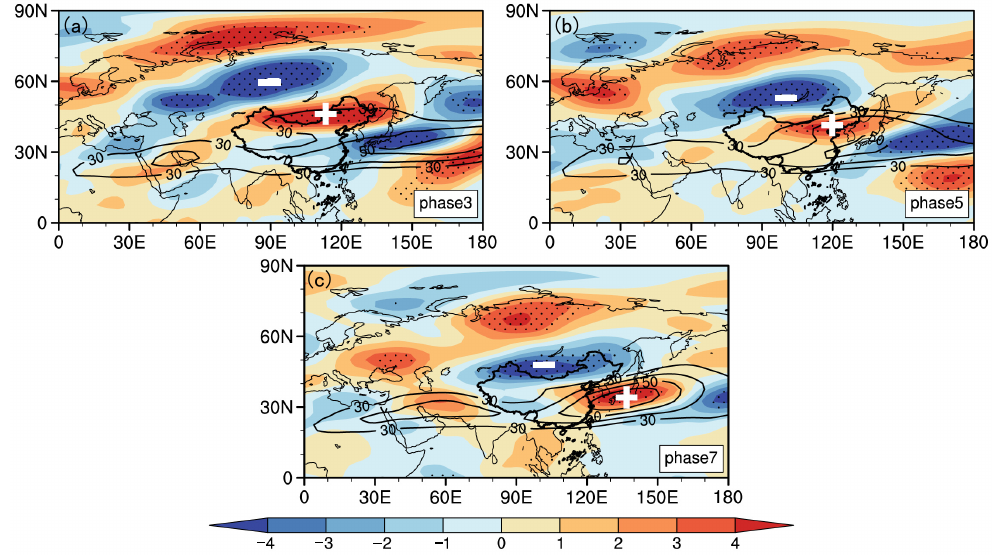
Figure 5. Low frequency 300 hPa zonal wind (shaded: 10–20 d component, dotted area encloses regions of larger than 0.01 significance; contour: westerly jet, unit: m/s) at phase 3 ( a ), 5 ( b ), and 7 ( c ), respectively.